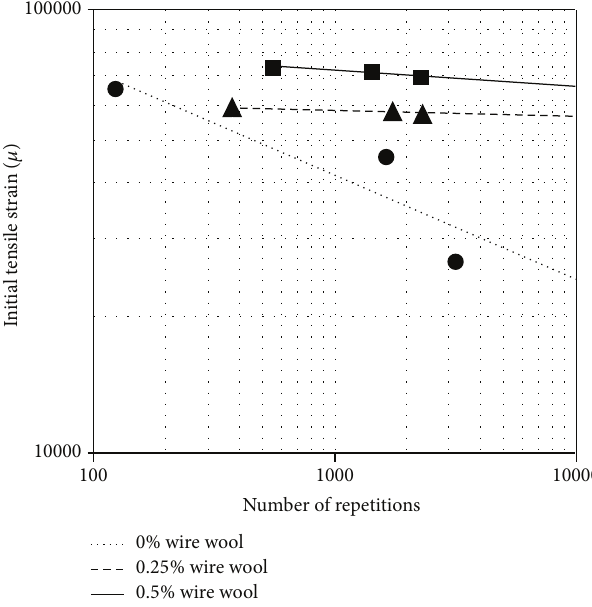
Figure 4: Fatigue behavior results for different HMA mixes.